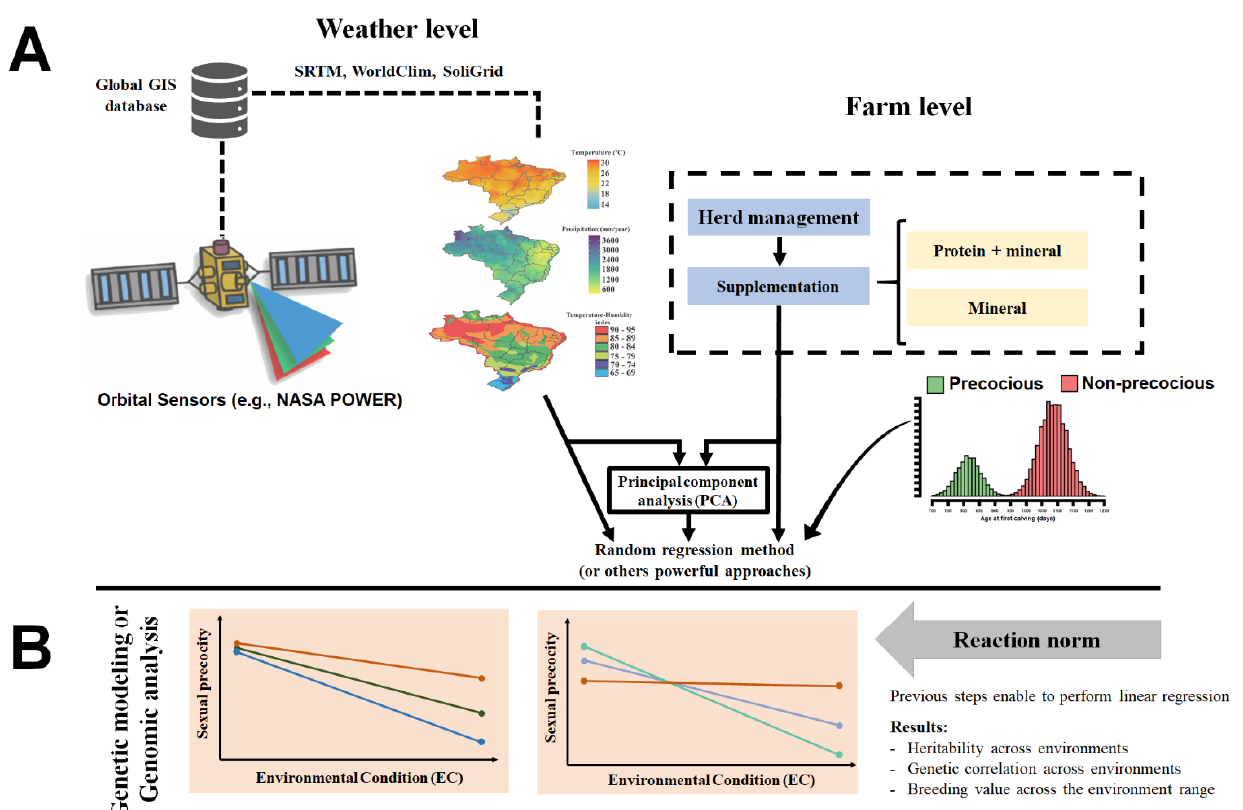
Figure 1. Schematic conceptualization for the evaluating of genotype by environment interaction in beef cattle raised in tropical regions. ( A ) An example of environmental gradient derived based on the combination of geographic information systems (GIS) and herd-level management. ( B ) Graphical representation of linear reaction norm evaluation of the response of breeding values to environmental changes.